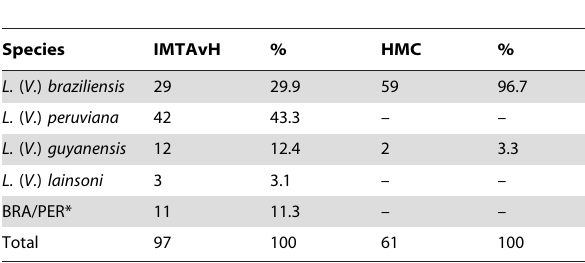
(*)No amplification for the MPI real-time PCR assay. 6PGD real-time PCR results suggested infection by either L. ( V. ) peruviana or L. ( V. ) braziliensis but in the